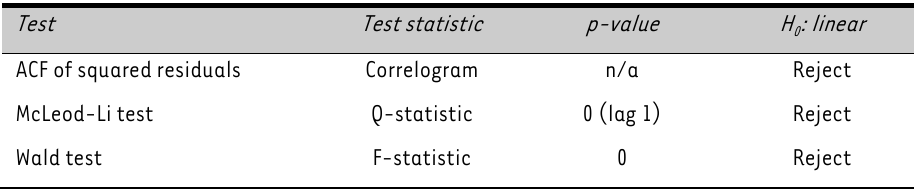
TABLE 1: Testing for